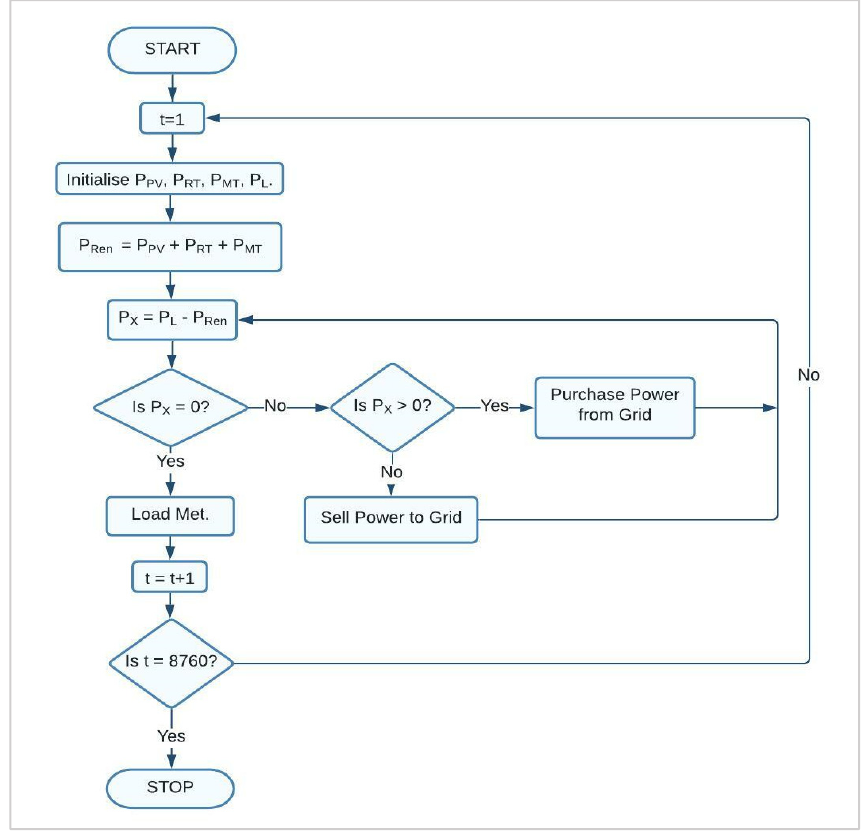
Figure 6. Flowchart of the dispatch strategy used for the modeled hybrid energy